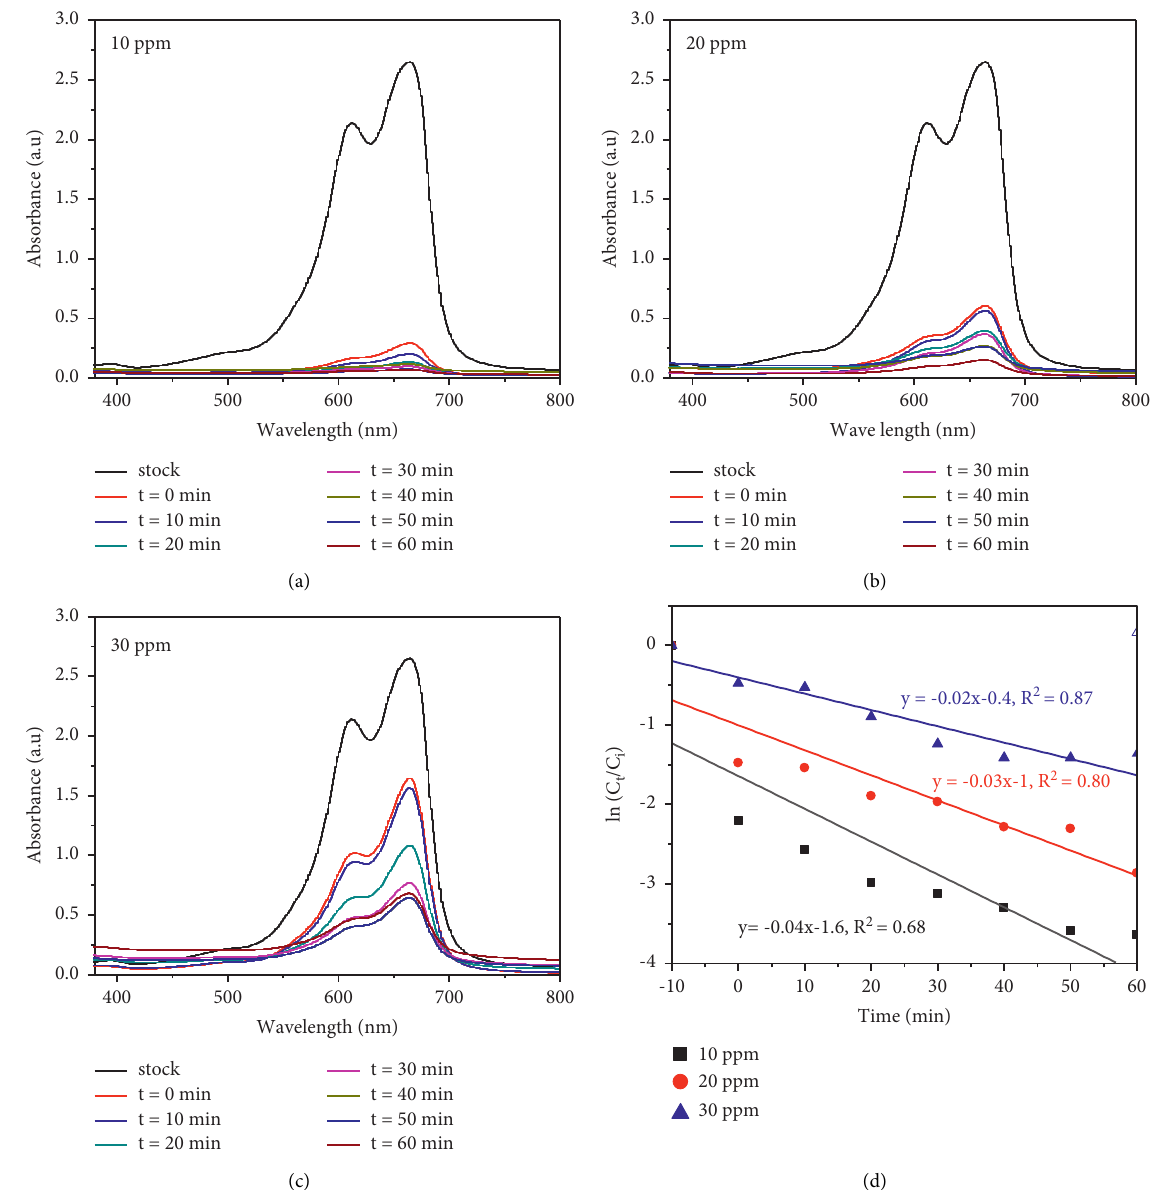
Figure 12: Effect of initial concentration of MB in the presence of synthesized TiO